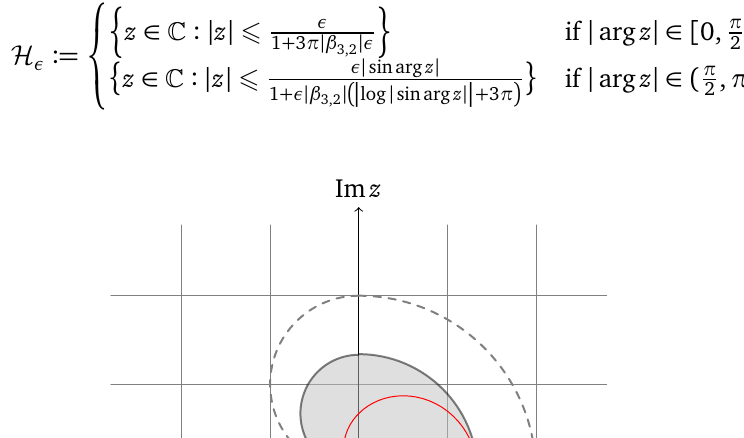
ε | = 1 , here 3 π | β ). The red (resp. 3,2 2 1 + 3 π | β 3,2 | ε (resp. of Ω ε ˜ ε